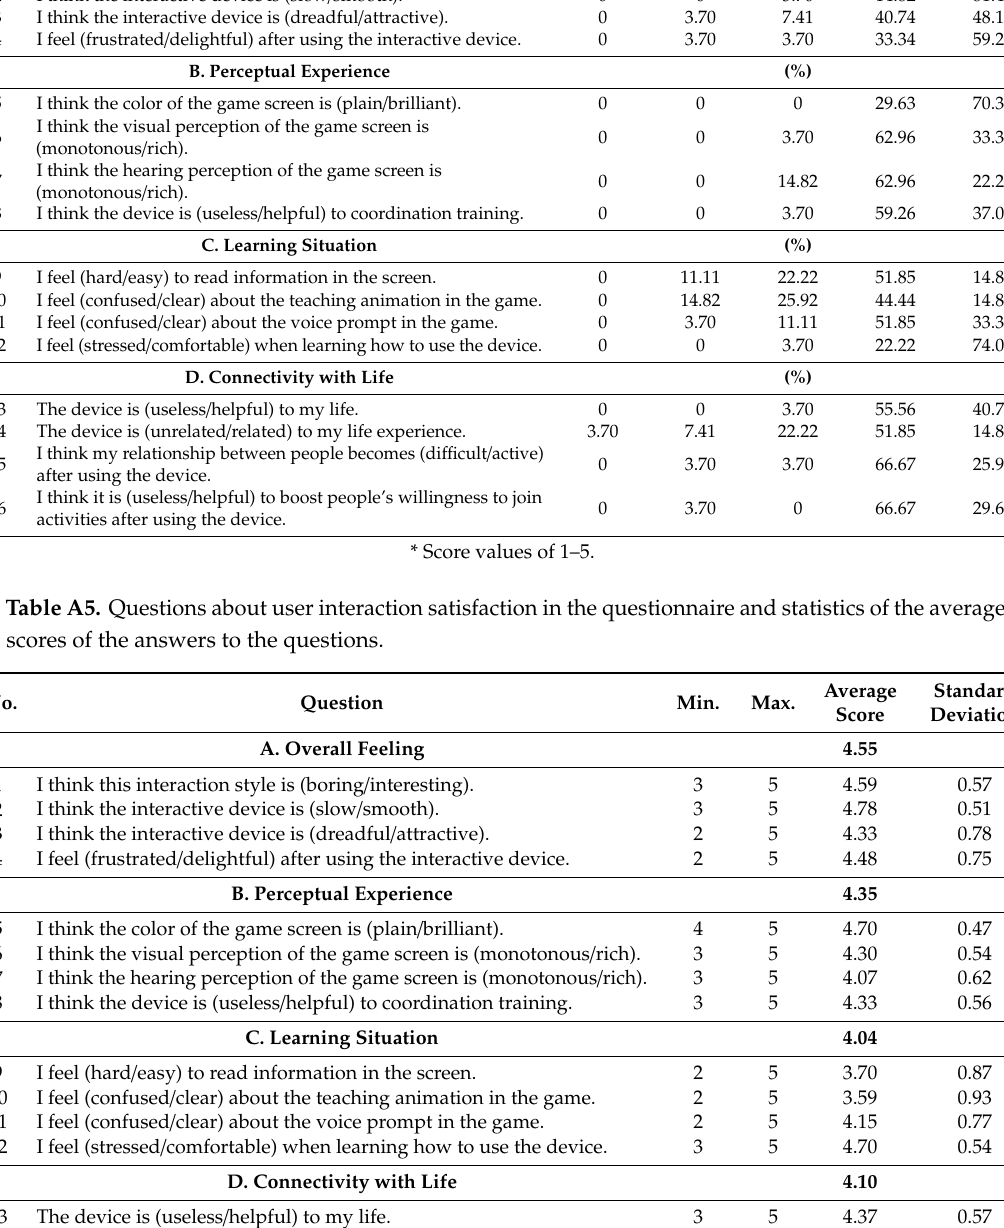
Table A4. Questions about user interaction satisfaction in the questionnaire and statistics of percentages of the scores of the answers to the questions.